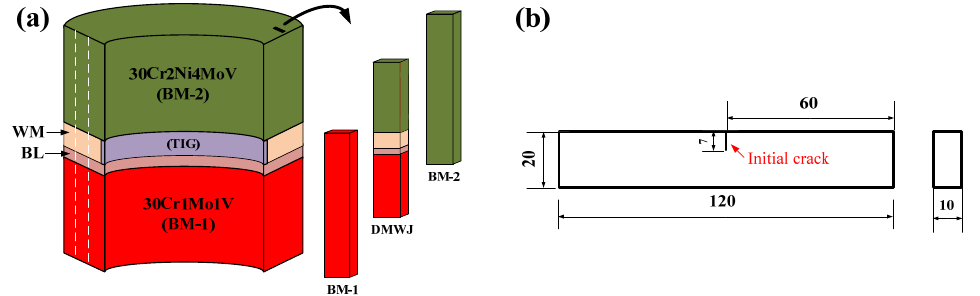
Figure 1. Welding structure, sampling method, and specimen size. ( a ) is welding structure and sampling method, ( b ) is specimen size Table 1. Chemical composition of base metals and filler wires (wt.%).